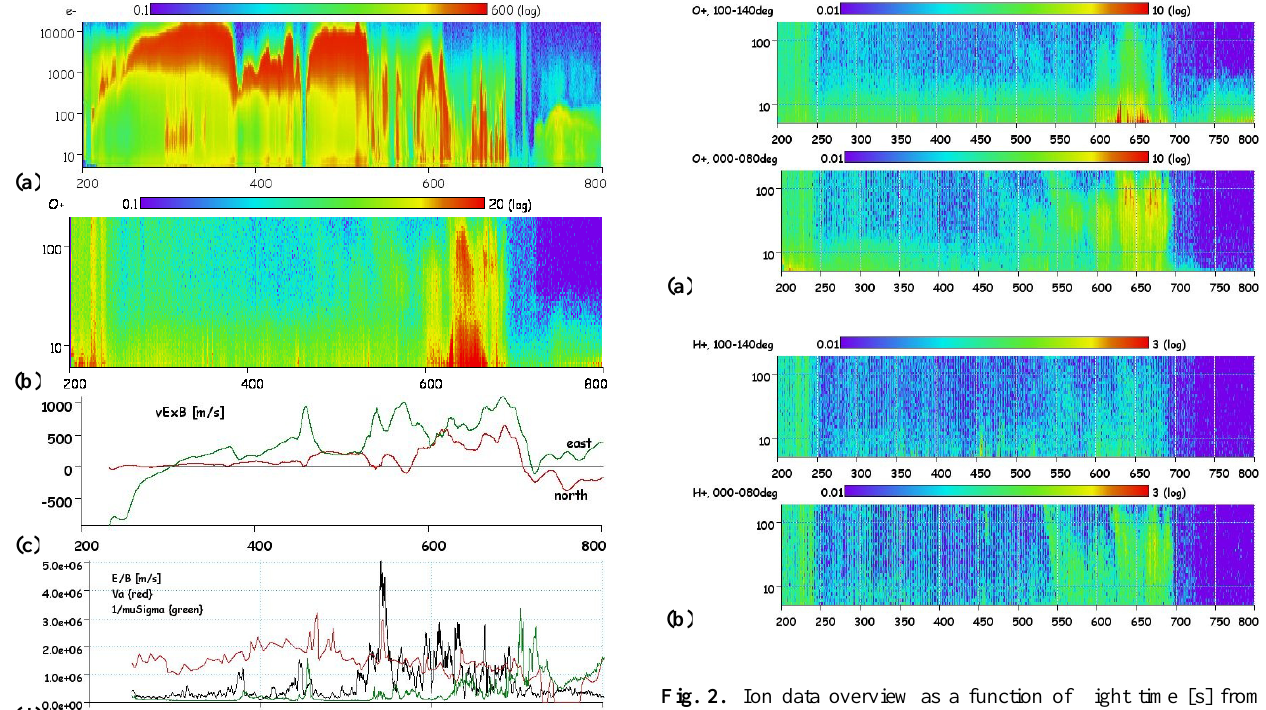
Fig. 2. Ion data overview as a function of flight time [s] from T+200s to T+800s. (a) : Energy spectra [eV] of oxygen, limited by pitch angle ranges of 100–140degrees (top) and 0–80degrees (bottom). (b) : Energy spectra [eV] of protons, limited by pitch angle ranges of 100–140degrees (top) and 0–80degrees (bottom). [Color bar proportional to differential energy flux eV/cm 2 /s/sr/eV, arbitrary